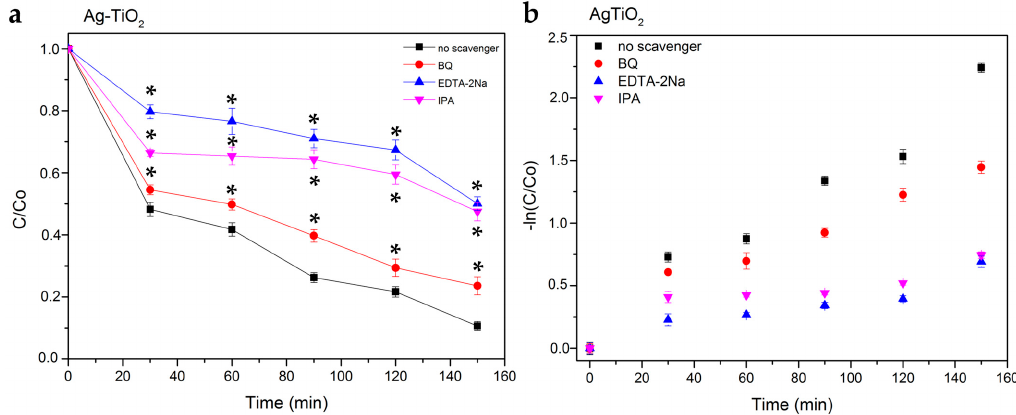
Figure 13. ( a ) Photocatalytic degradation curves of RhB in the presence of Ag-TiO 2 and the radicals’ scavengers (ethylenediaminetetraacetic acid disodium salt (EDTA-2Na), benzoquinone (BQ) and isopropanol (IPA)). The data represent means ± standard deviation from three experiments. In these series of experiments, * p < 0.05 was considered statistically significant. ( b ) Photocatalytic kinetics of the same samples, according to a linear pseudo-first-order model. Table 3. Linear correlation coefficients (R 2 ) and photocatalytic degradation rate constant (k app ) for all the scavengers.